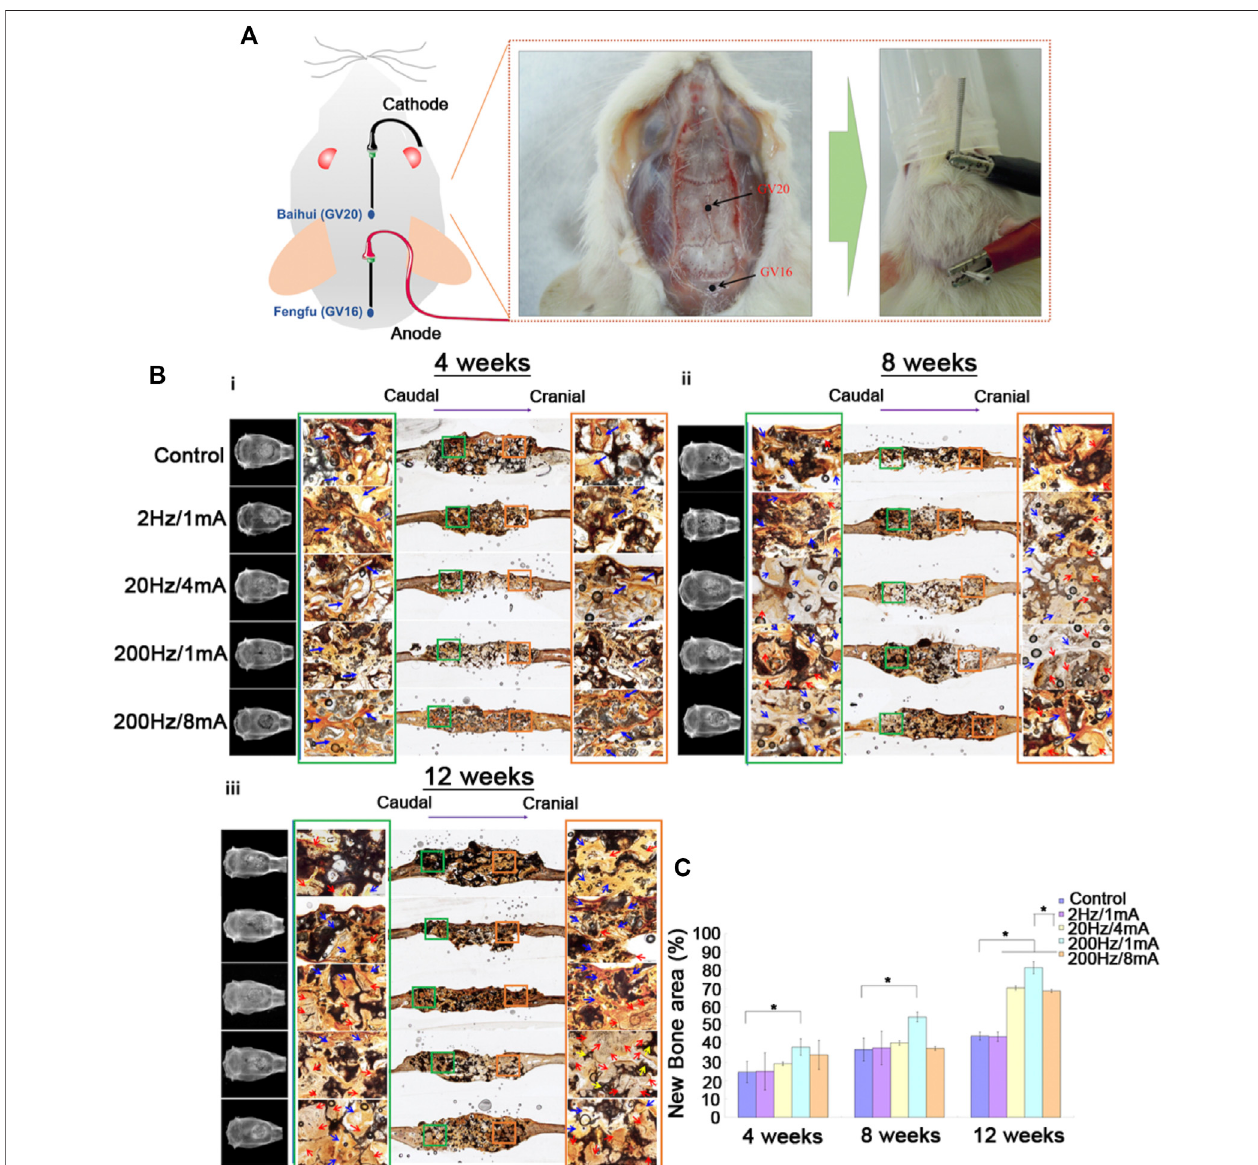
FIGURE2 | (A) Photographic imagesofthe bone-defected rats with the implanted GGTscaffold undergoing electroacupuncturestimulation on Baihui (GV20) and Fengfu (GV16) acupoints. [ (B) (i)-(iii)] The micro-CT and histological images of the new bone regenerative behavior of rats were treated with electroacupuncture stimulation for 4, 8, and 12 weeks. (C) The quantitative results of the new bone regrowth area in the defects of rats treated with electroacupuncture stimulation for 4, 8, and 12 weeks. The control group indicated the rats with the implanted GGT scaffold and without ES treatment. (The number of rats per group = 4, * p <